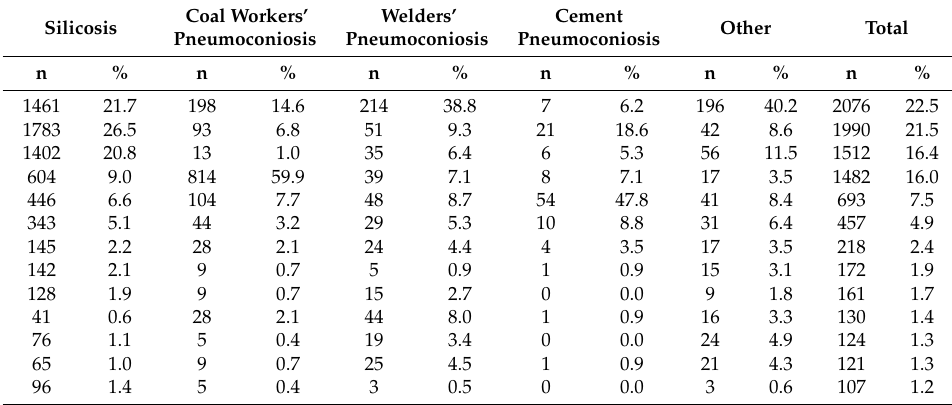
Table 1. The regional distribution of pneumoconiosis cases reported from 2006 to